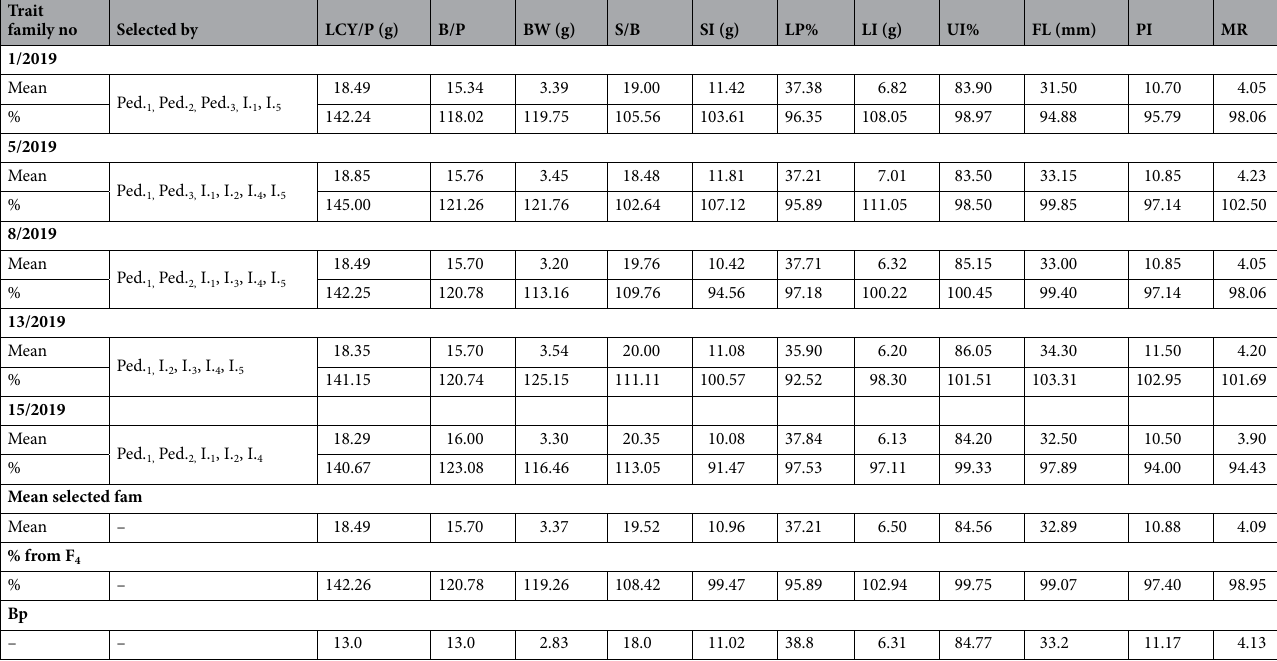
Table 5. Means and their percent from the better parent of the superior four families scored by using two selection procedures for studied characters in the F 4 generation. Where; % = (Mean of the superior families/ Mean of BP) × 100.